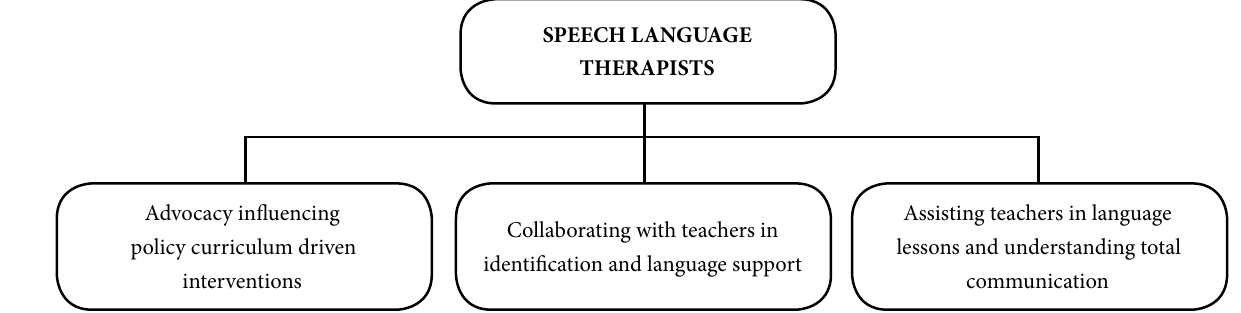
Fig. 2. Proposed role of SLTs in ordinary linguistically diverse South African